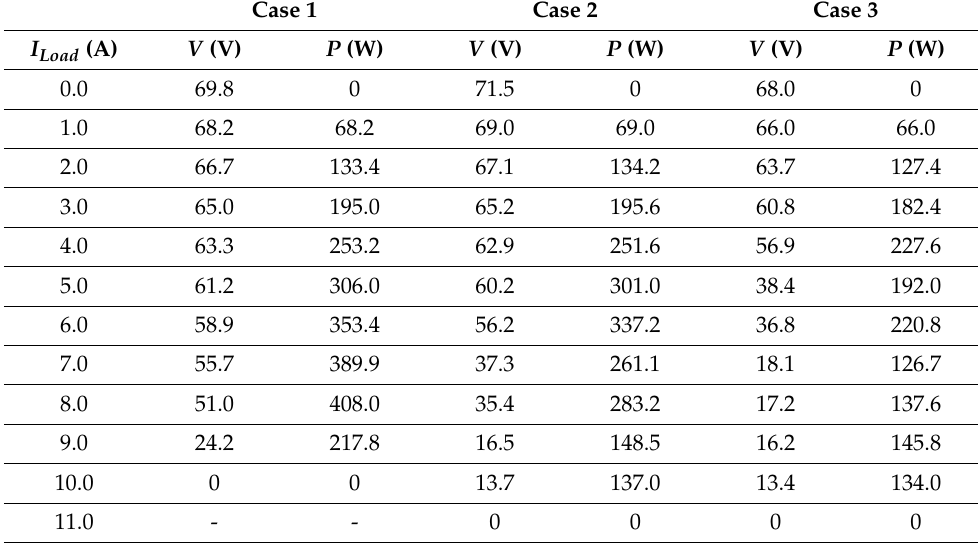
Table 5. Experiment Results of Multiple Series Connections of PVEs for Case 1, 2, and 3.